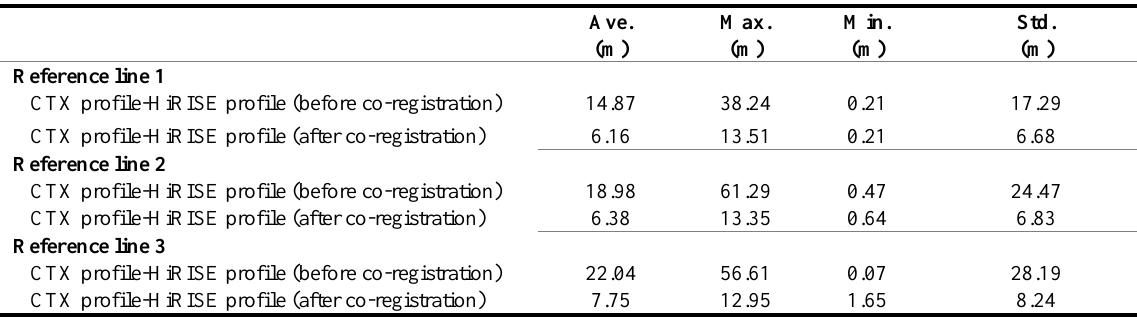
Table 4. Statistics of the elevation differences between the profiles derived from the CTX and HiRISE